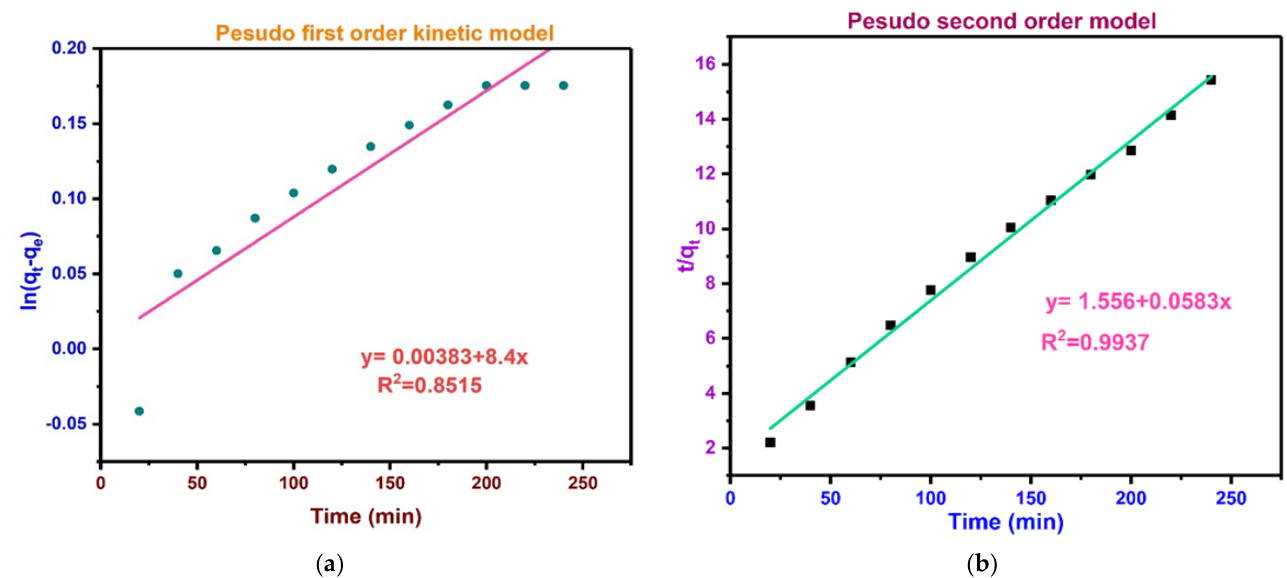
Figure 14. ( a ) Pseudo-first order model for adsorption of BPA by MBC, and ( b ) pseudo-second order model for adsorption of BPA by MBC. Table 5. Kinetic study result for BPA adsorption.